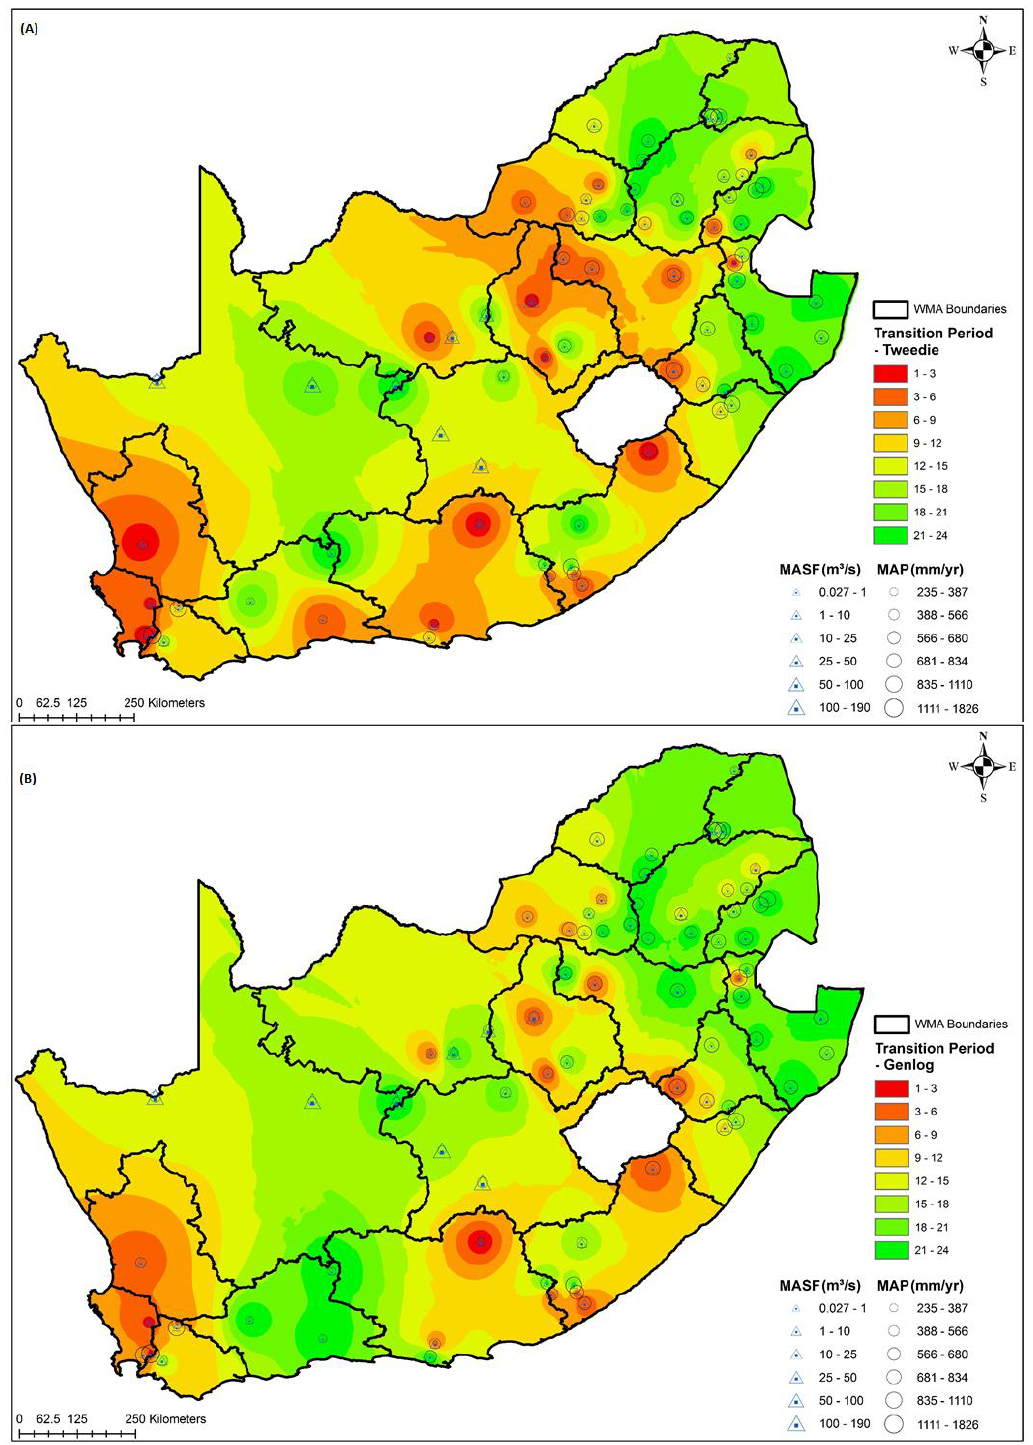
Figure 9. The drought transition period from meteorological to hydrological calculated using the three-parameter statistical distribution functions: ( A ) Tweedie and ( B ) Generalized Logistic.